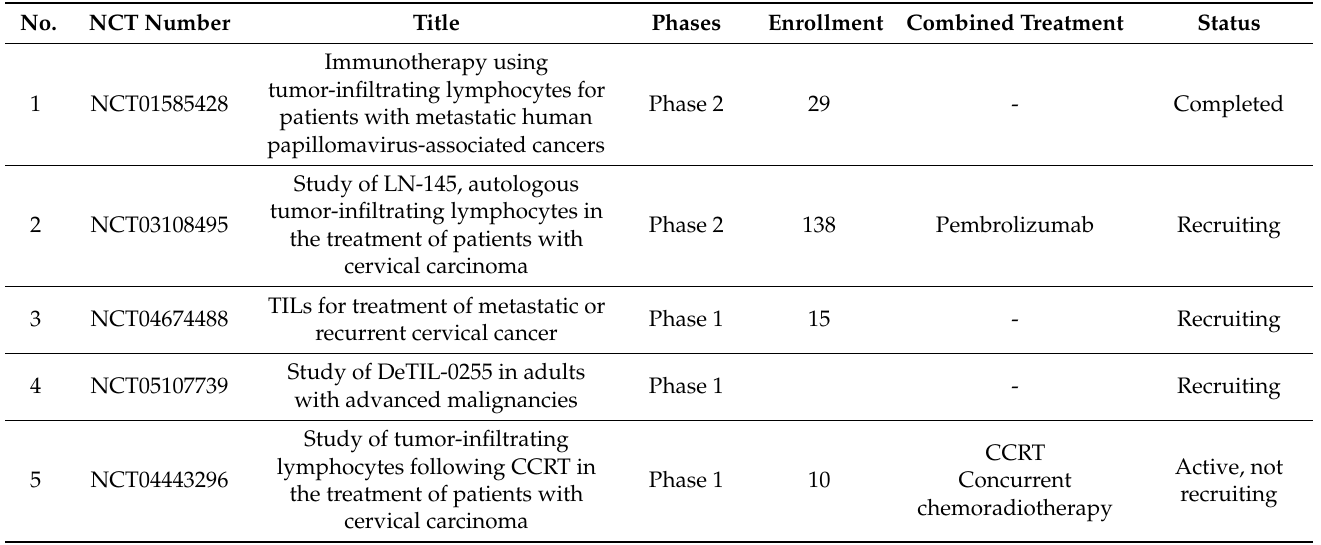
Table 2. Shows 5 registered trials of TILs on the web of clinical